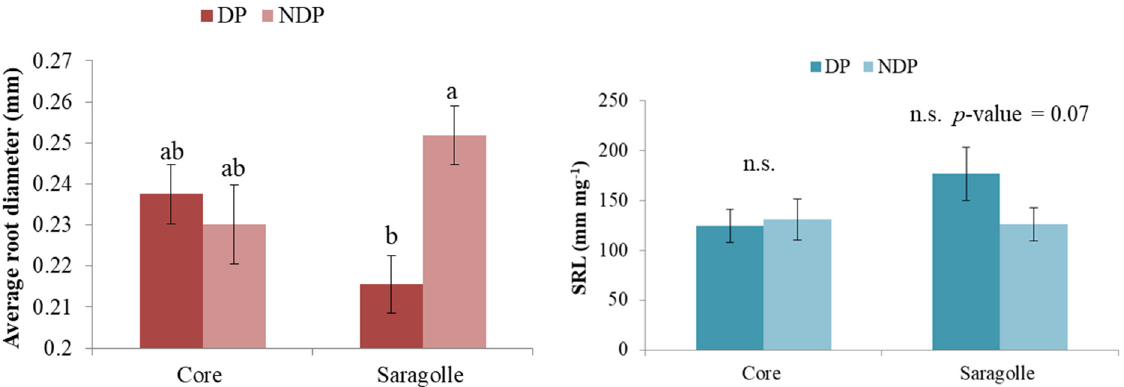
Figure 8. Left: interaction of wheat variety and clipping management on root average diameter, bar plots of the means overlaid by standard error bars; different lowercase letters over the bars depict significant differences between means ( p -value < 0.05). Right: interaction of wheat variety and clipping management on specific root length (SRL), bar plots of the means overlaid by standard errors bars with indication of significance (n.s.= non significant ).